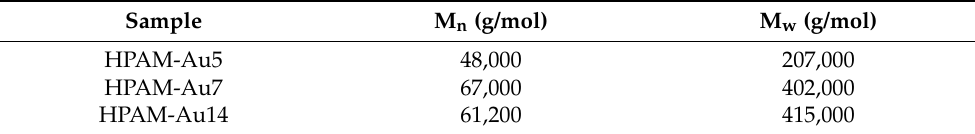
Table 1. Molecular weight values of nanocomposites.